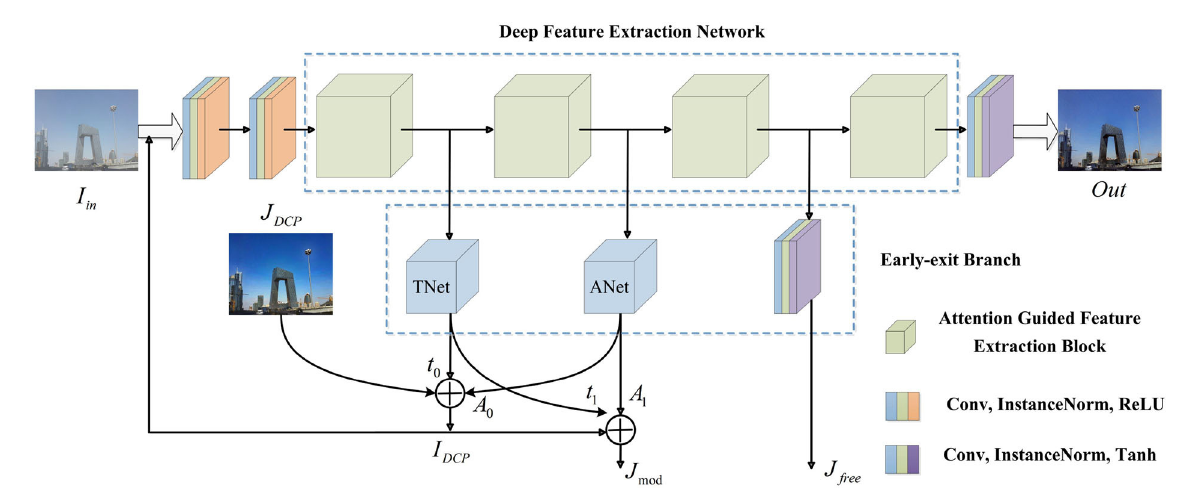
FIGURE2 The general network structure of PMGSDN. TNet, the network adopted to estimate transmission map. ANet, the network adopted to estimate atmospheric light.